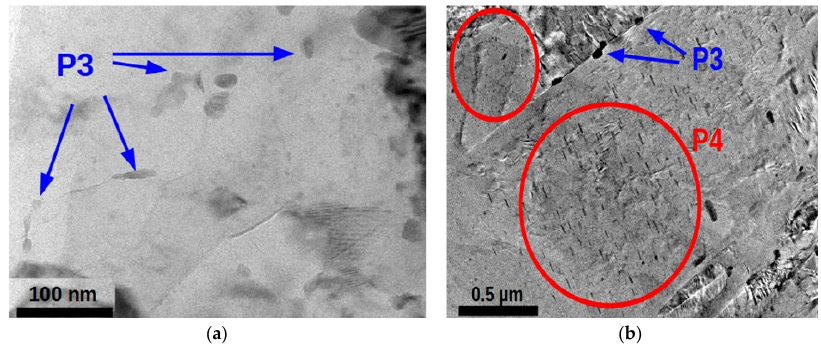
Figure 19. TEM images of the HPT ‐ processed (0.5 rot) and heat ‐ treated Mg5Zn0.3Ca sample ( a ) at 100 °C for 24 h and ( b ) HPT processed and heat treated at 125 °C for 24 h showing P3 and P4 precipitates.